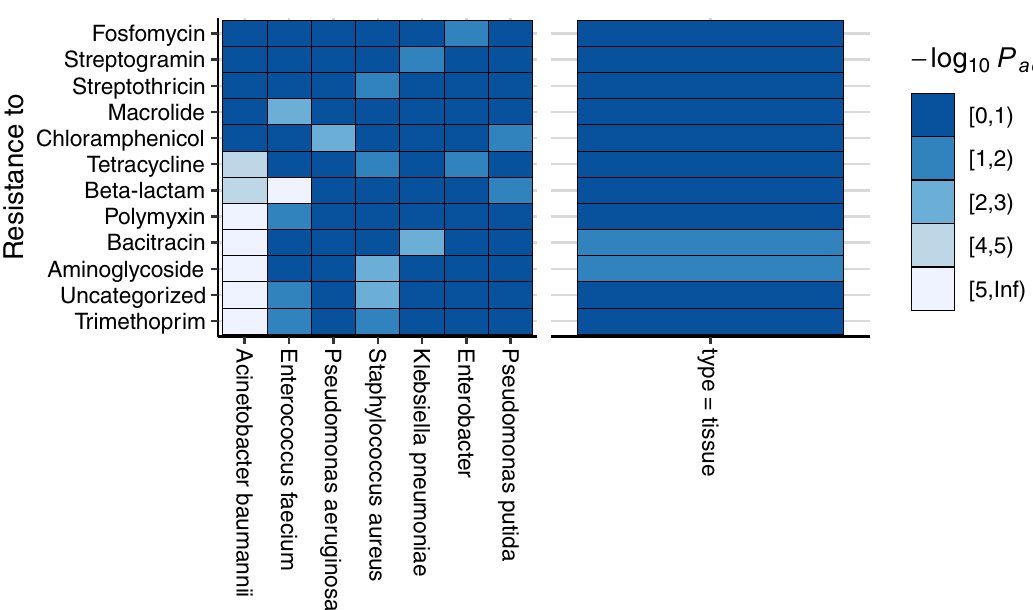
Figure 4. Association of AMR signature classes with detection of nosocomial pathogens. Logistic regression models were built to determine whether detection of defined genomic resistance signatures associates with metagenomic read abundance of specific genera corresponding to nosocomial pathogens. Resistance to drug classes are rows and nosocomial pathogens are columns. The sample collection type is included as an independent variable in each model with the type = tissue as compared to type = effluent shown as a separate column for reference. Significance (false discovery rate adjusted P-value) is indicated through color fill on a − log10